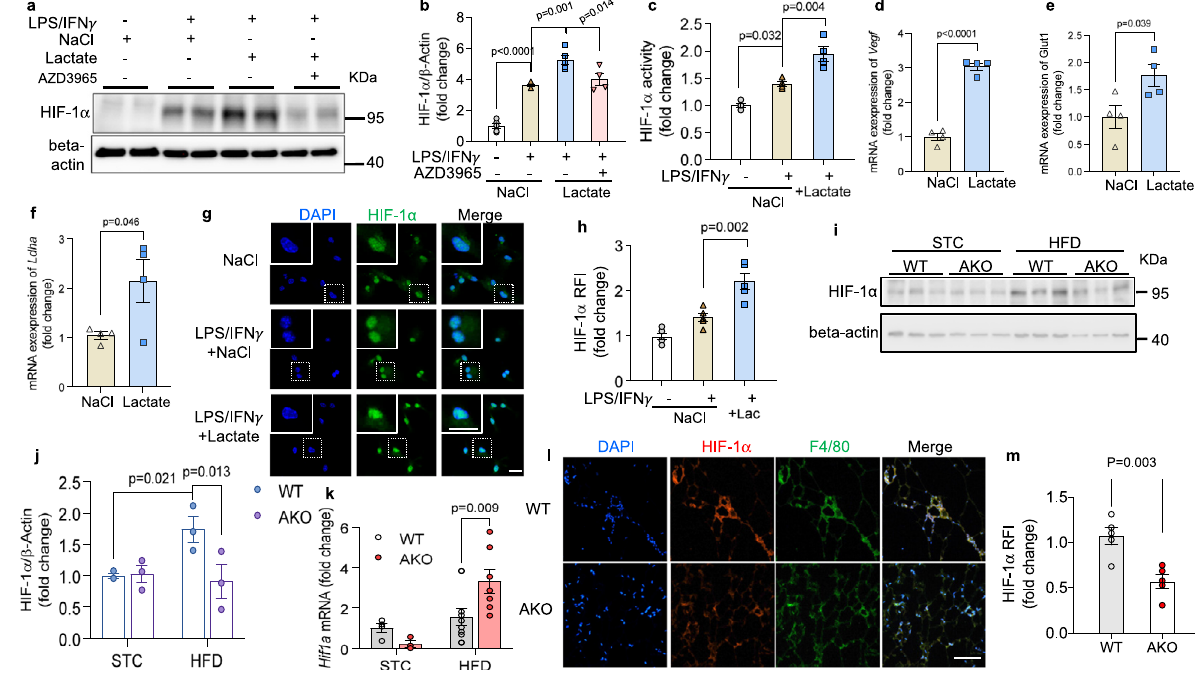
Fig. 5 | HIF-1 α protein level is increased by lactate in pro-in fl ammatory mac- rophages. a – h Mouse BMDMs were treated with lactate (20mM) orNaCl(20mM) and AZD3965 (100nM). a Western blotting of HIF-1 α in macrophages. b Densitometryquanti fi cationofHIF-1 α levelby Westernblotting. c HIF-1 α activity in macrophages. M0: n =5; M1: n =5; M1+Lac: n =5; M1+Lac+MCTi: n =4 biolo- gically independent samples. d – f mRNA expressions of HIF-1 α downstream genes. n =4 biologically independent samples. g Immuno fl uorescence staining of HIF-1